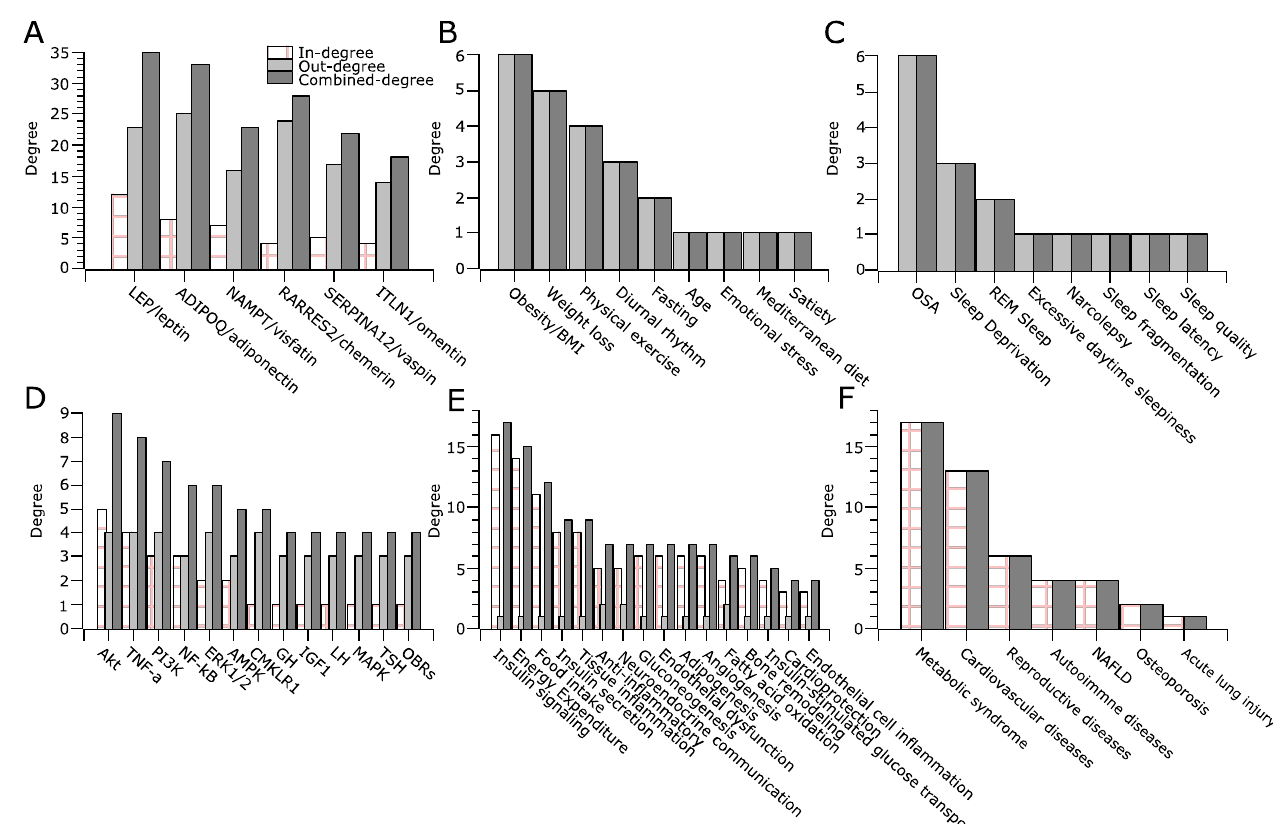
Figure 2. Degree analysis of the adipokine network representing adipokines ( A ), physiologic per- turbations ( B ), sleep disturbances ( C ), molecular targets ( D ), physiologic functions ( E ), and relevant disease processes ( F ). Among them, physiologic perturbations ( B ) and sleep disturbances ( C ) only have out-degree, and disease processes ( F ) only have in-degree. Adipokines ( A ), molecular targets ( D ), and physiologic functions ( E ) have in-degree, out-degree, and combined degrees. Only selected molecular targets and physiologic functions are shown.